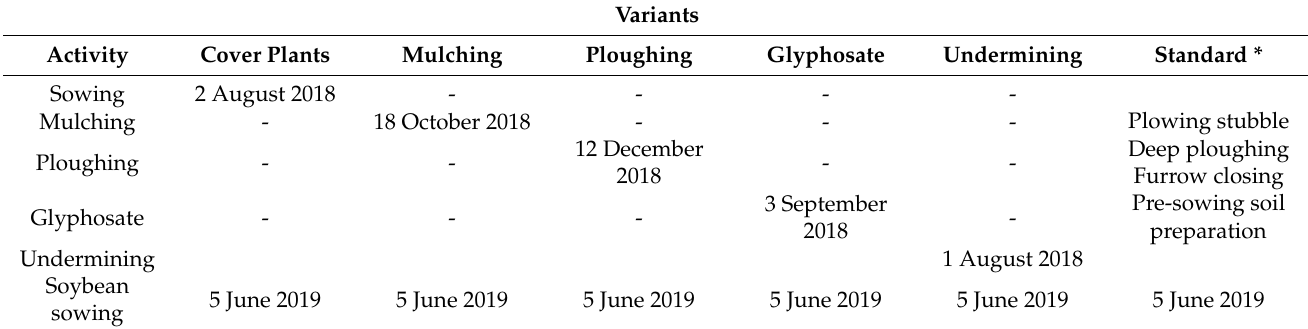
Table 1. Pre-sowing interventions and implementation